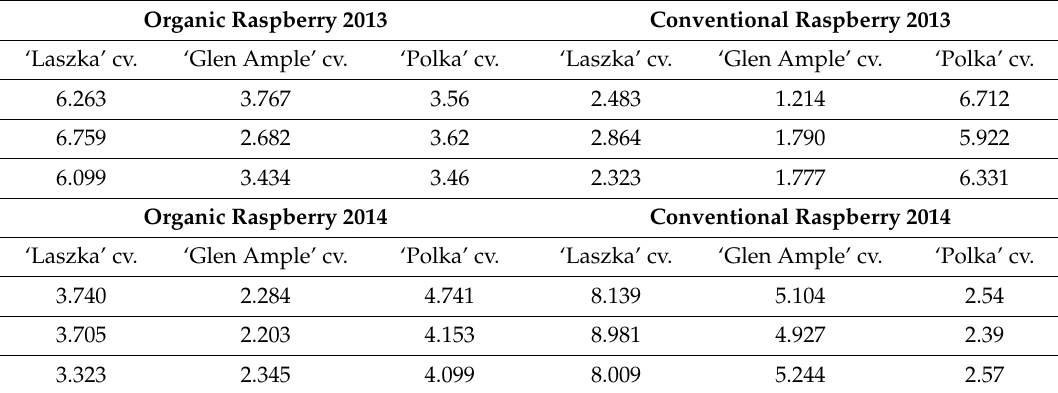
Table 5. The content of profilins as ELISA results µ g / g